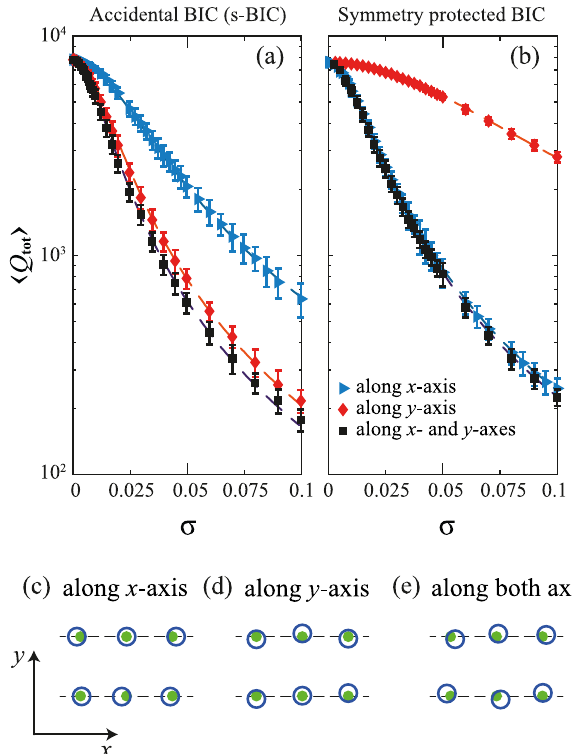
of disordered structures on Figure 2: Dependence of average Q tot disorder amplitude 𝜎 for (a) the accidental s-BIC and (b) the symmetry-protected sp-BIC. Bars indicate the standard deviation. Number of periods N = 100. Schematic view of the rod array with the structural disorder (c) along x -axis, (d) along y -axis and (e) along both axes. Green solid circles show the ordered structure, blue open circles show the structures with disorder.